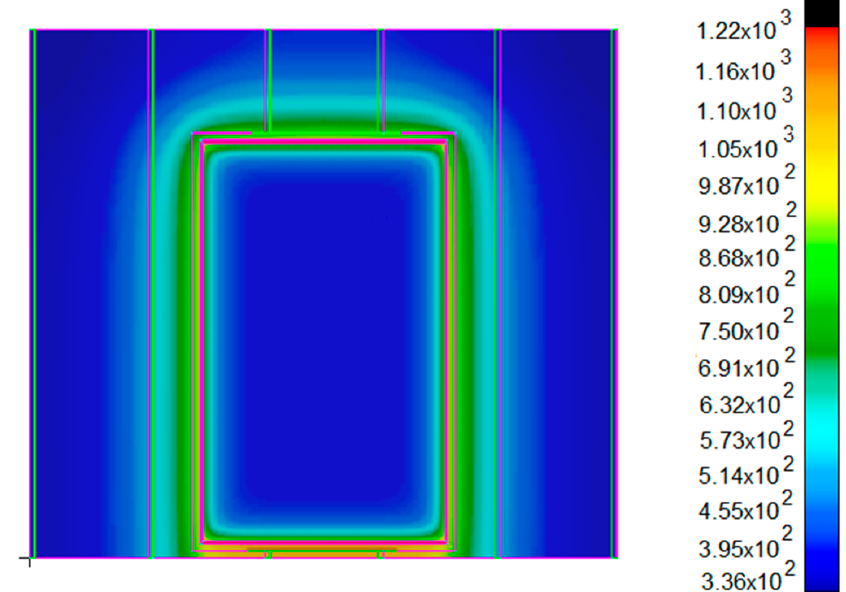
Figure 6. Temperature distribution on the fire-unexposed side of the door at the final stage of the fire test (60 min); scale in (K). Table 2. Comparison between modelled—using, respectively, Eurocode and self-consistent convection coefficient—and measured temperatures; error estimation and validation of the self- consistent model.